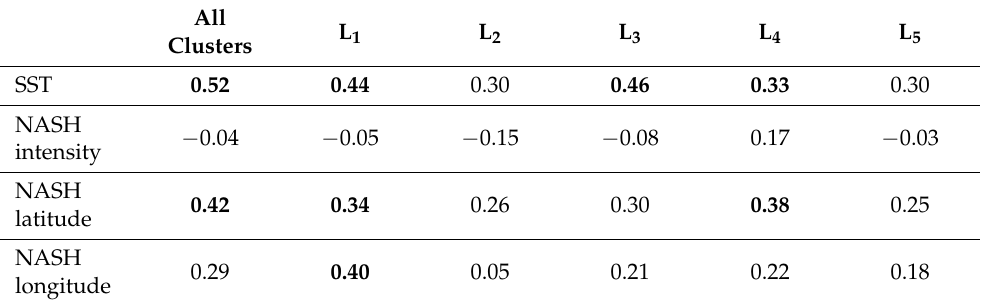
Table 3. Pearson’s correlation coefficients between annual time series of mean SST, the NASH intensity, and NASH position (center latitude and longitude) (June to November) with the landfalling counts in the whole NATL (L 1 + ... + L 5 ) and each cluster. Statistical significance is marked with bold text ( p < 0.05). NASH latitude and NASH longitude represent the NASH center latitude and NASH center longitude, respectively.